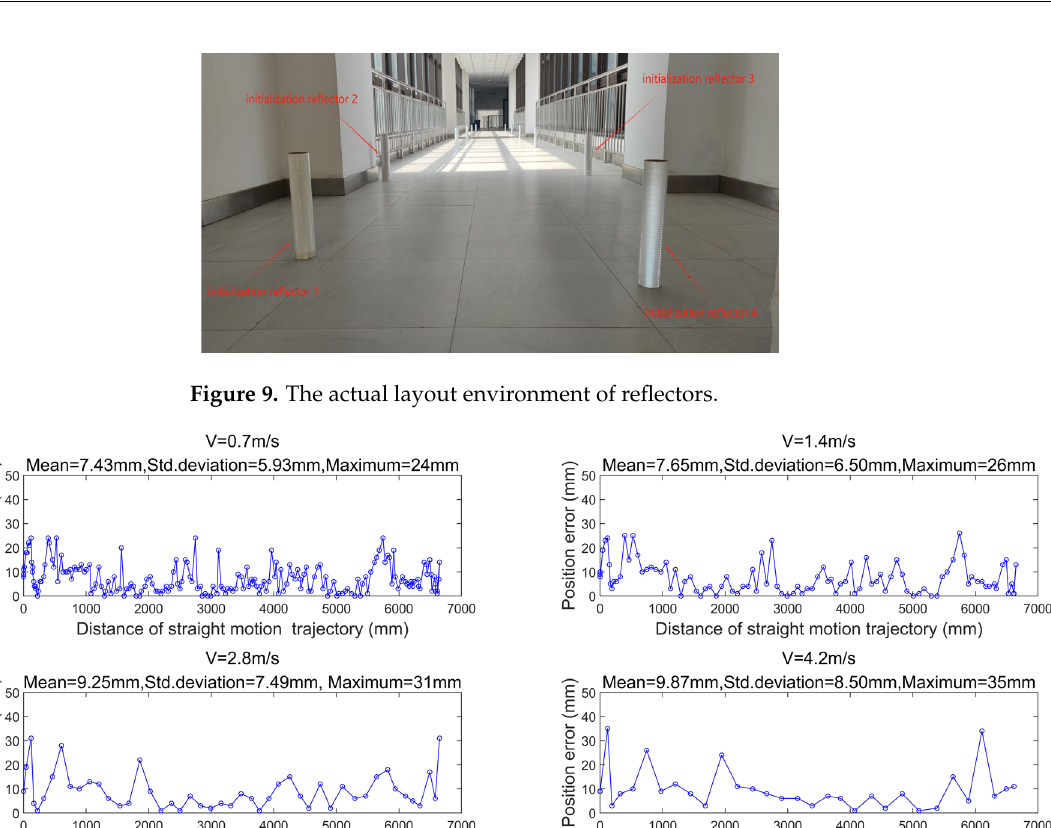
( b ) Figure 11. Robot motion trajectory and navigation map: ( a ) motion compensation mode turned on; ( b ) motion compensation mode turned off.